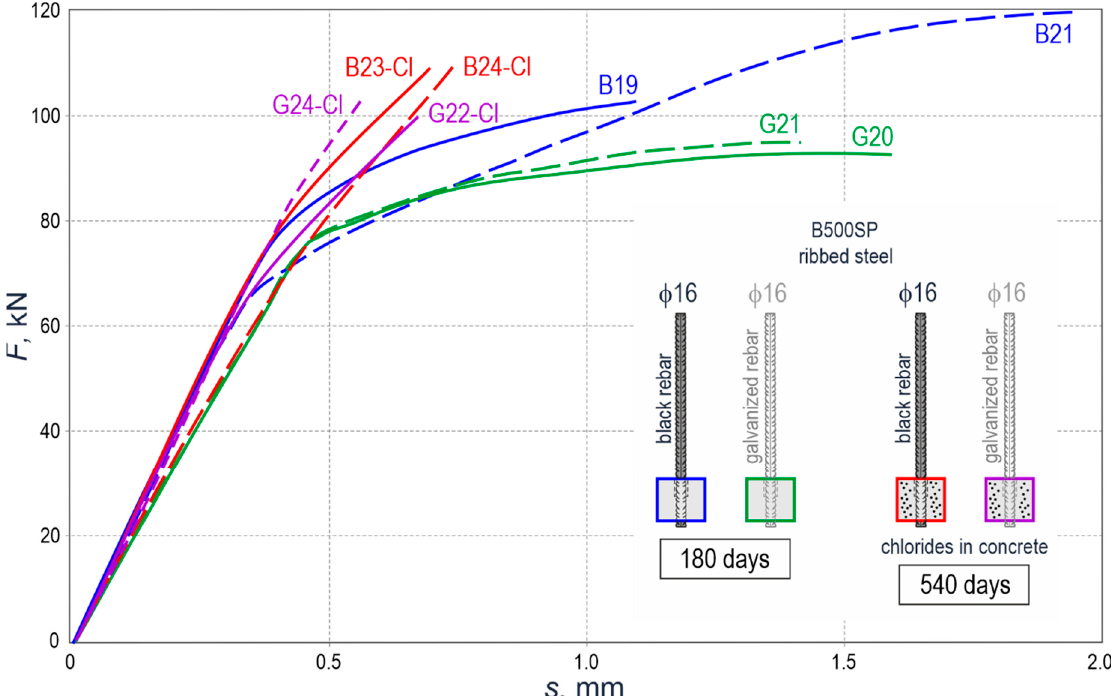
Figure 12. The relationship between the pull-out force F [kN] and the shift s [mm] during the pull-out of the galvanized and black steel rebar from concrete. This relationship, based on the Aramis system, was determined for rebars ϕ 16 mm from steel grade B500SP—the tests performed after 180 and 540 days.